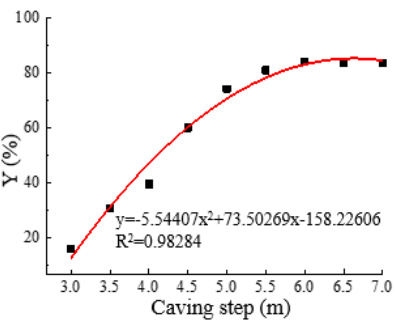
Figure 12. Relationship between ore dilution ratio and caving step.